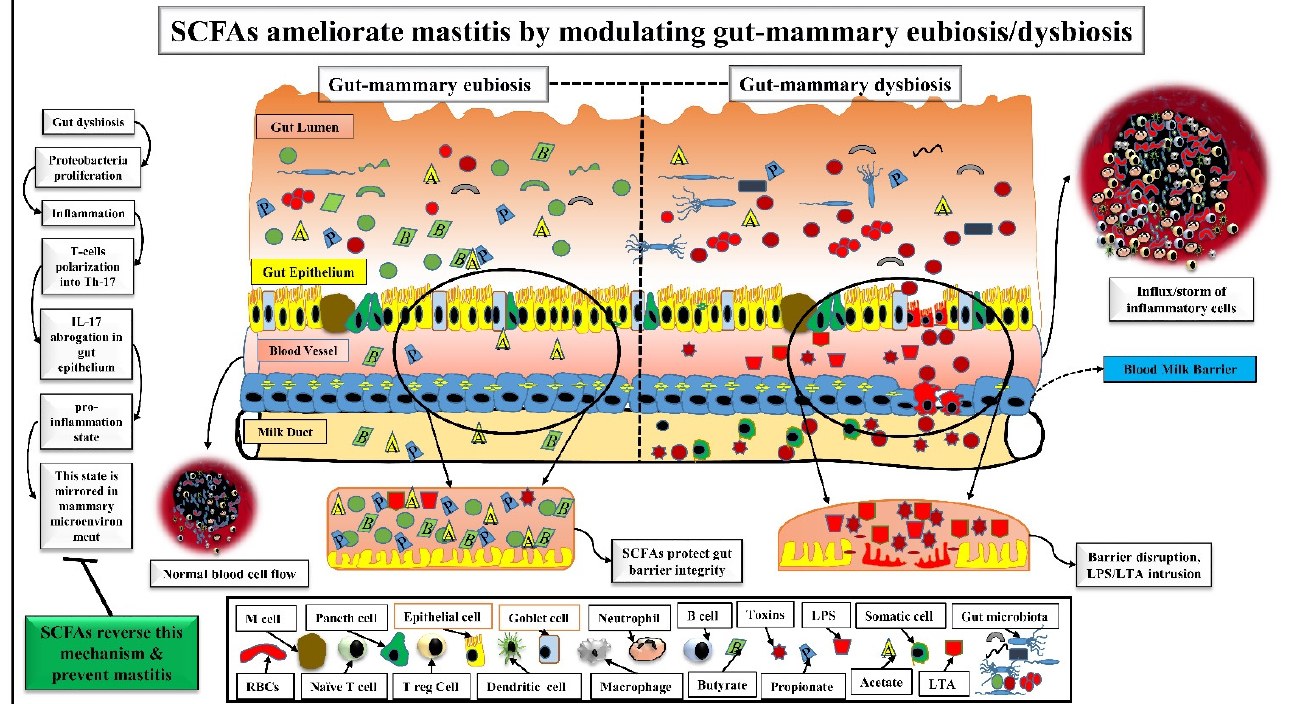
Figure 2. SCFAs ameliorate mastitis by modulating gut-mammary eubiosis/dysbiosis. Gut-mammary dysbiosis and inflammation are represented on the right side of the figure. Gut dysbiosis increases pathogenic invaders and decreases the commensals in the gut lumen. As a result, gut pathogens start their proliferation and initiate a low-grade inflammation, which damages the gut epithelial barrier, and several pathogens including S aureus (shown in red-color-filled circles) also intrude into the systemic circulation. After their intrusion, a storm of inflammatory cells initiates at the inflammatory injury site. Bacteria-released LPS, LTA, and toxins in the host circulation damage the blood milk barrier and get entry into the milk duct, where somatic cells also rush towards the inflammation site. On the other hand, gut-mammary eubiosis and homeostasis are represented on the left side. Here, the gut lumen is enriched with beneficial bacteria (shown in the green color) that maintain homeostasis. As a result, the gut epithelial barrier remains